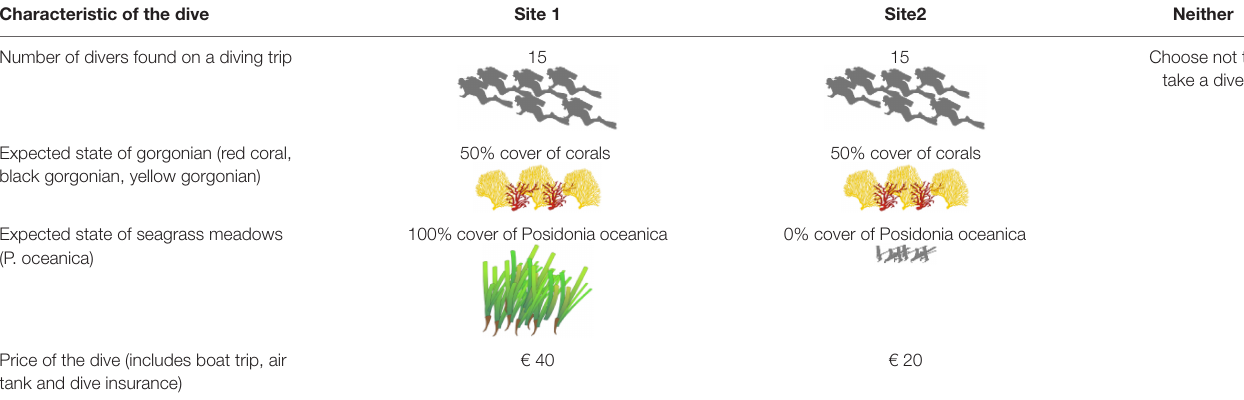
TABLE 1 | Example of choice set. Characteristic of the dive Site 1 Number of divers found on a diving